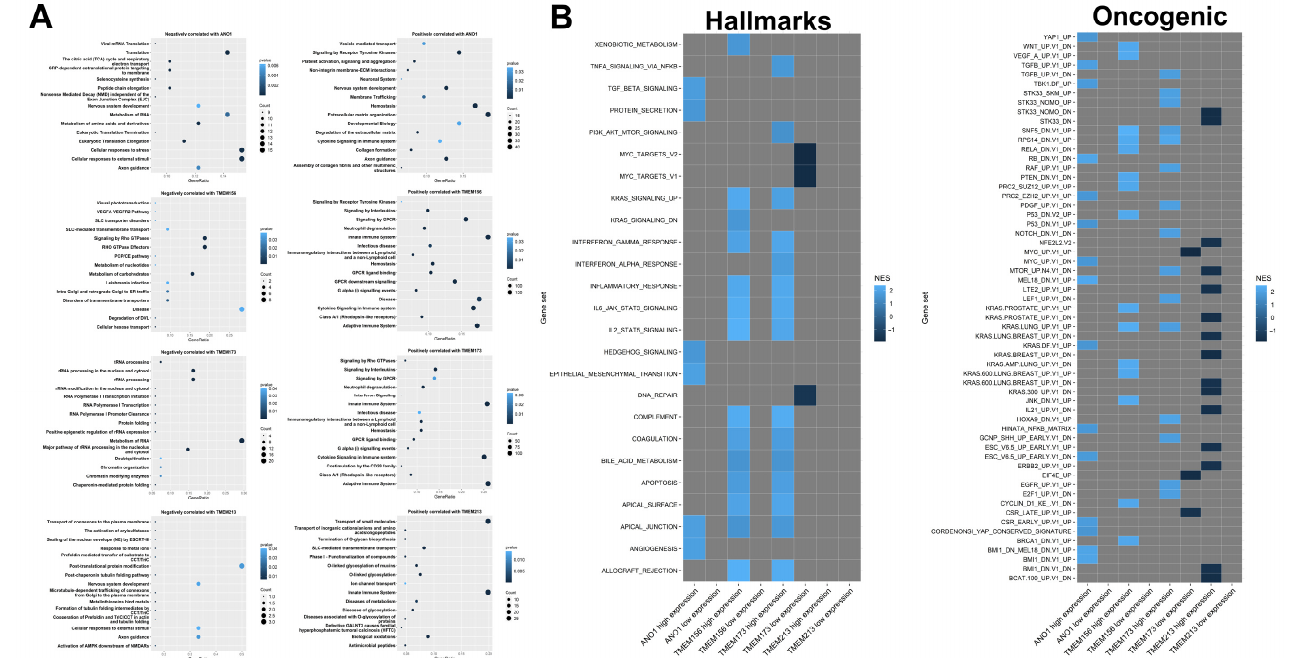
Figure 5. Differences in HNSCC phenotype depending on the expression level of ANO1 , TMEM156 , TMEM173, and TMEM213 . ( A ) REACTOME pathway enrichment analysis of genes positively (R > 0.3) and negatively (R < − 0.3) correlated with ANO1 , TMEM156 , TMEM173, and TMEM213 . Fifteen statistically significant ( p < 0.05) pathways with the highest gene count are shown; ( B ) Genes sets significantly ( p < 0.05 and FDR < 0.25) enriched in high and low ANO1 , TMEM156 , TMEM17, and TMEM213 expression phenotypes with regard to hallmarks (H) and oncogenic (C6) gene sets based on GSEA analysis; gray squares indicate lack of